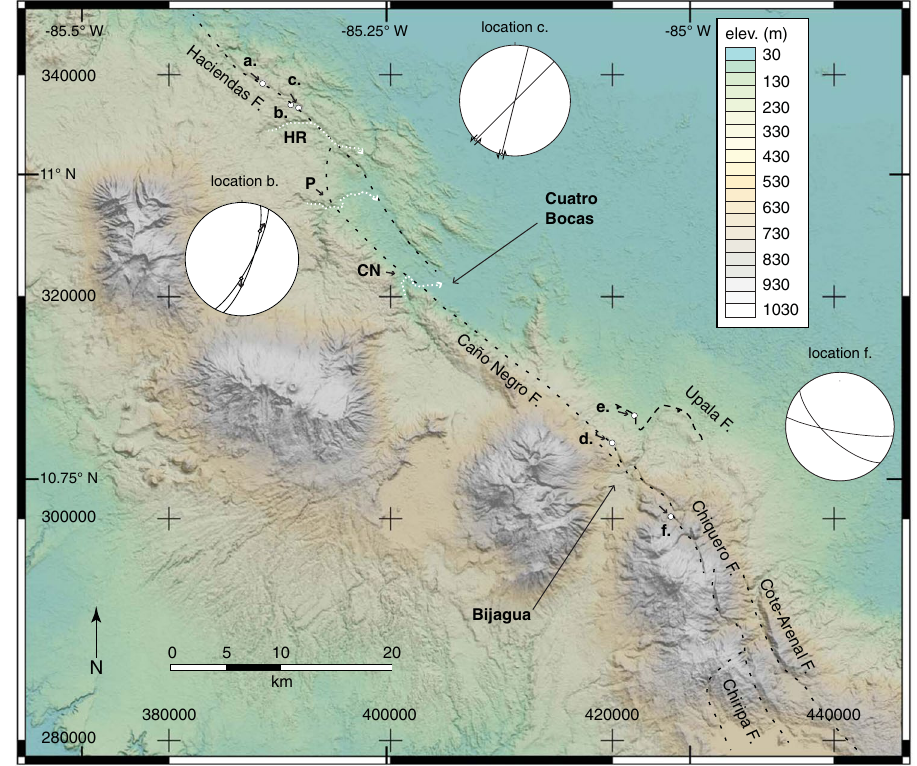
Figure 3. Haciendas-Chiripa fault system. Digital elevation model and shaded relief map derived from enhanced SRTM data with an effective resolution of 30 m. Lighting is directed from an azimuth of 020°. Mapped fault segments are named and the locations of the major fault traces are shown with dashed lines. Lower-case bold letters a.–f. with short arrows showing view direction of lettered photos at Fig. 4. Lower-hemisphere equal- area projections show structural data described in text. CN = Caño Negro River, HR = Haciendas River and P = Pizote River. Map generated using QGIS version 2.14 with SRTM 1 Arc-Second Void Filled digital elevation data courtesy of the U.S. Geological Survey from https://earthexplorer.usgs.gov/. Keys, labels and symbols were added using Adobe Illustrator CC 2015